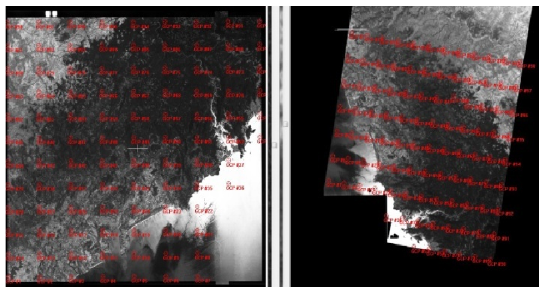
Figure 3. Grid of GCPs for RPC generation